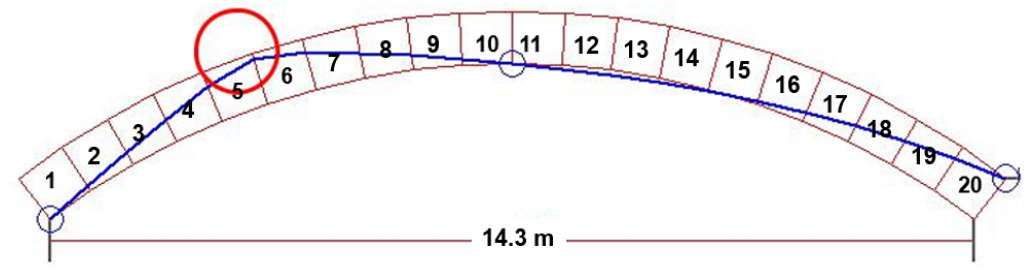
Figure 10: Thrust line of the Porta Napoli arch, after Heyman’s Limit analysis.